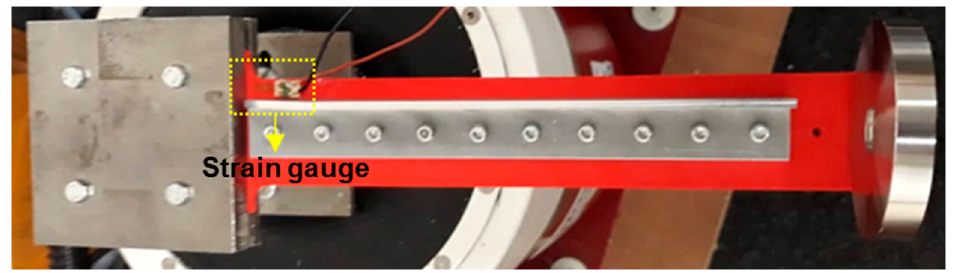
Figure 4. Strain gauge instrument and placement on the sample.